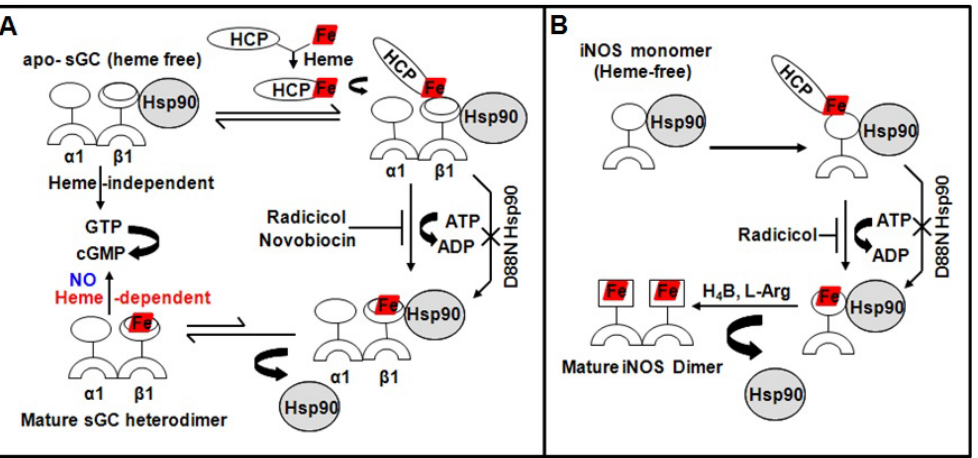
Figure 3. Representations depicting similarities in Hsp90–apo–protein interactions with respect to heme deplete/replete states of sGC ( A ) and iNOS ( B ). HCP indicates an ultimate heme carrier protein which may eventually be Hsp90.